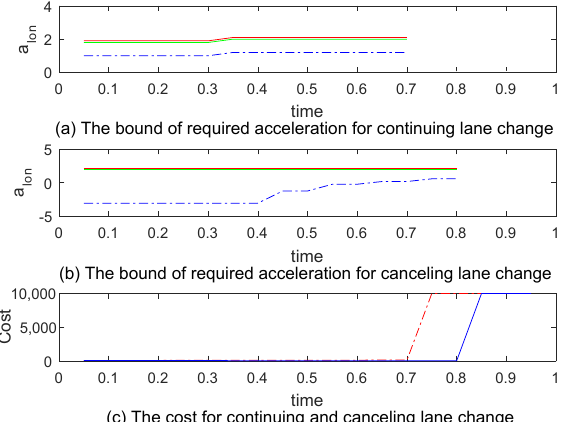
Figure 16. The maneuver evaluation result at 0.95 s with a lon =